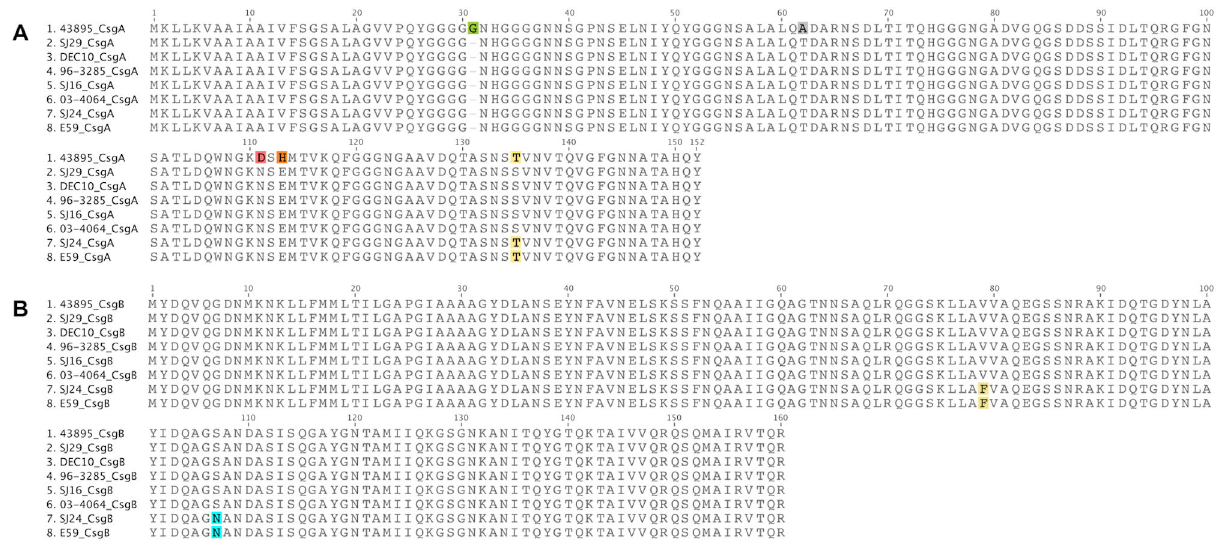
Figure 4. Protein alignments of CsgA (A) and CsgB (B) from selected STEC strains. doi: